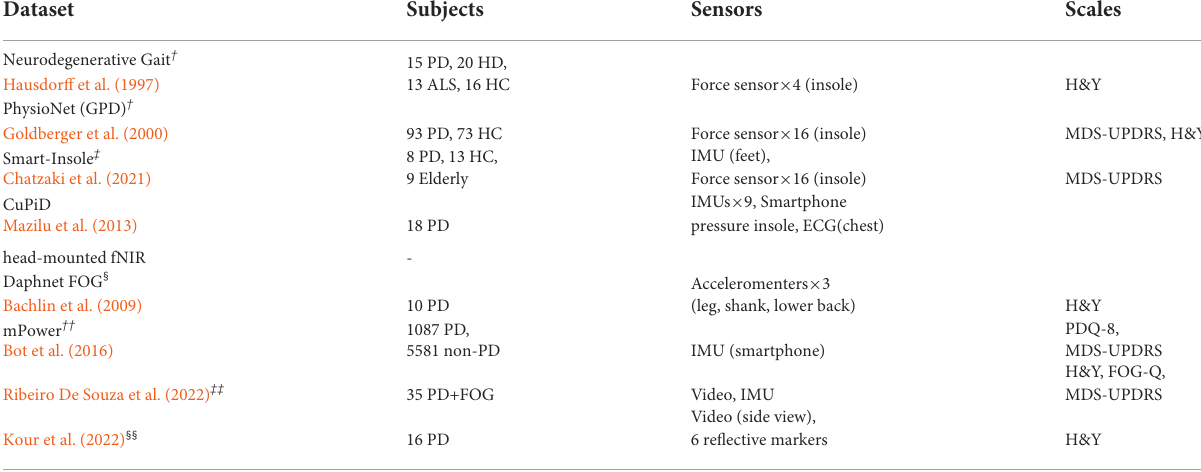
TABLE 6 Summary of publicly available datasets for gait-based PD